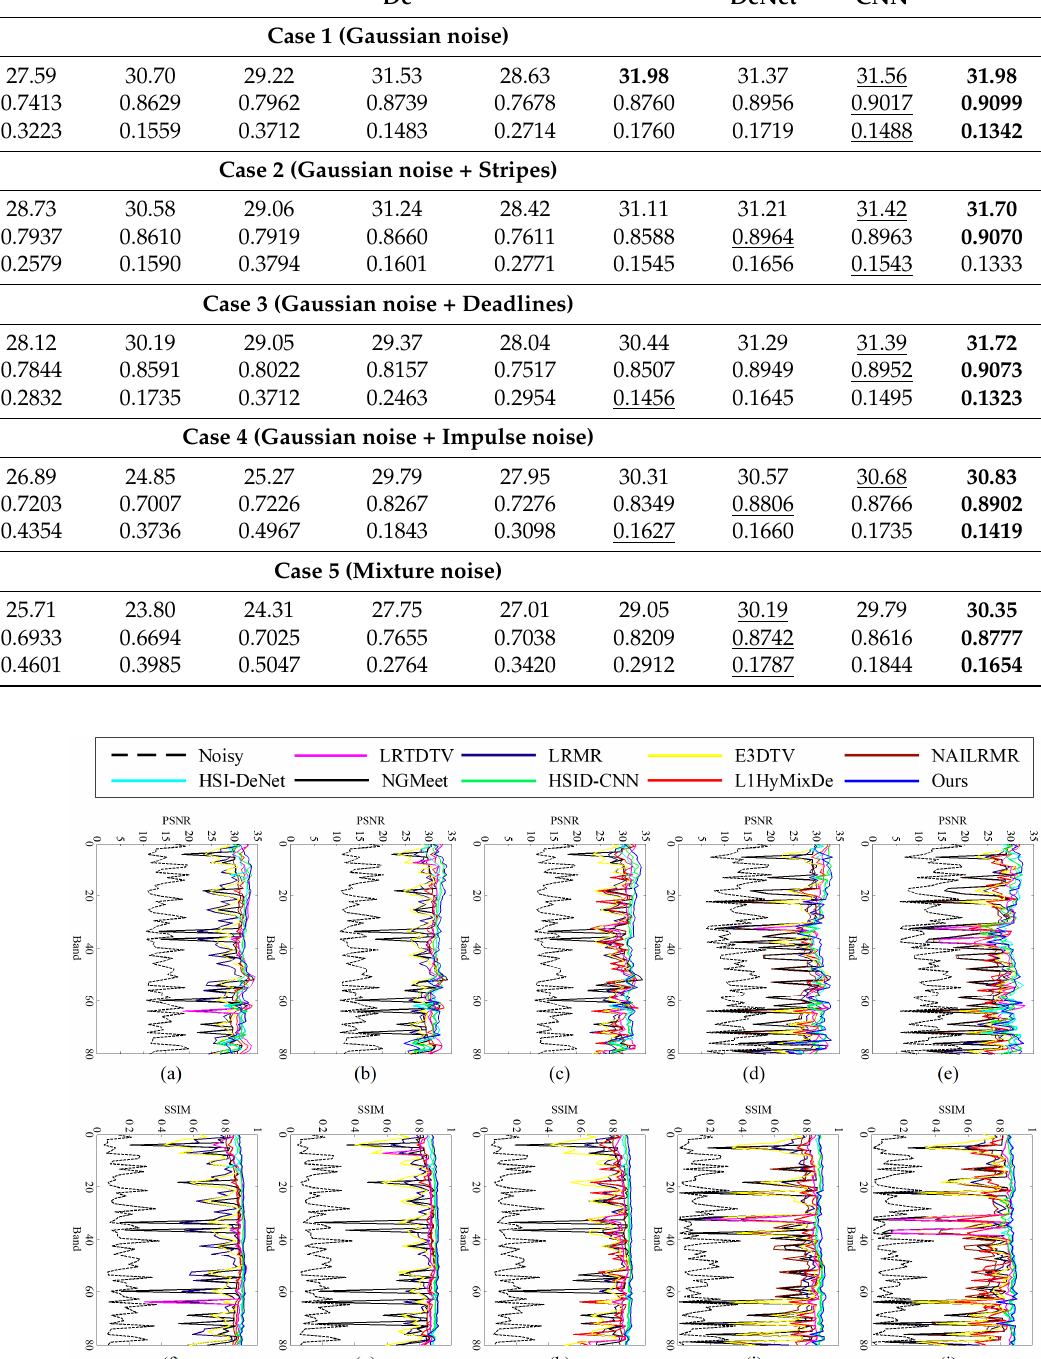
Table 3. Quantitative assessment of different algorithms applied to Pavia Centre data with mixture